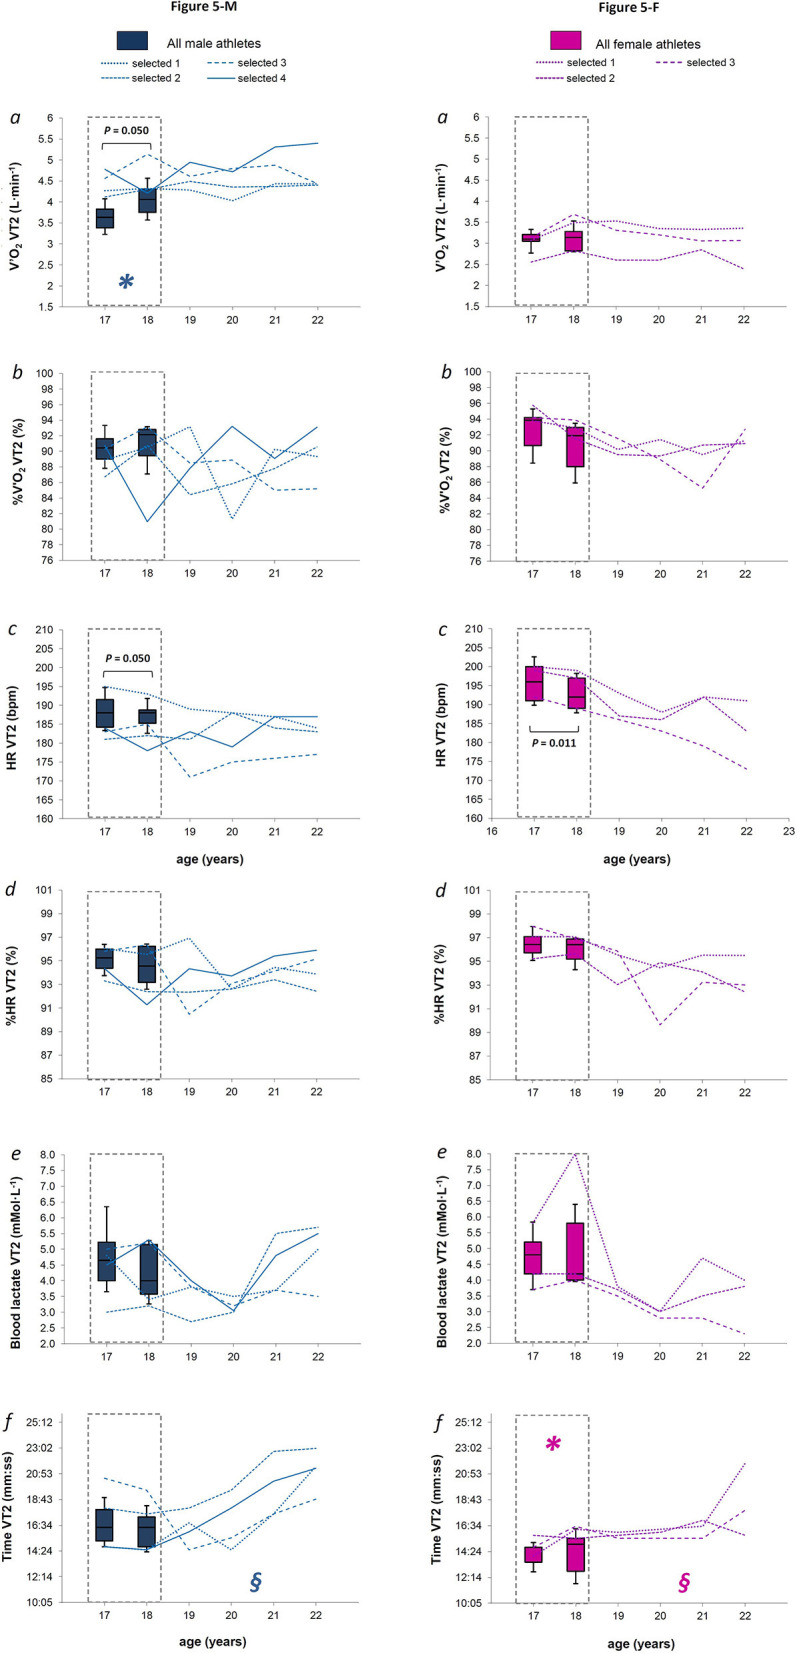
Figures 5-M and 5-F. For males and females (Figures 5-M and 5-F, respectively), the box plot represents medians, 9, 25, 75, and 90th percentiles of the values measured at the second ventilator threshold (VT2) for absolute oxygen consumption (panel a), relative oxygen consumption (panel b), absolute heart rate (panel c), relative heart rate (panel d), blood lactate concentration (panel e), and time of second threshold occurrence (panel f) measured over the late teenage period (data in dotted-lined boxes) in the entire group. The P-value refers to the statistical age effect during the late teenage period. In each panel, the line plots represent each selected athlete from 18 to 22 years of age. § indicates a likely effect of age after the late teenage period, while * indicates possible parameters early identifying further athletes' selection, when all the criteria presented in the statistical analysis paragraph were satisfied.